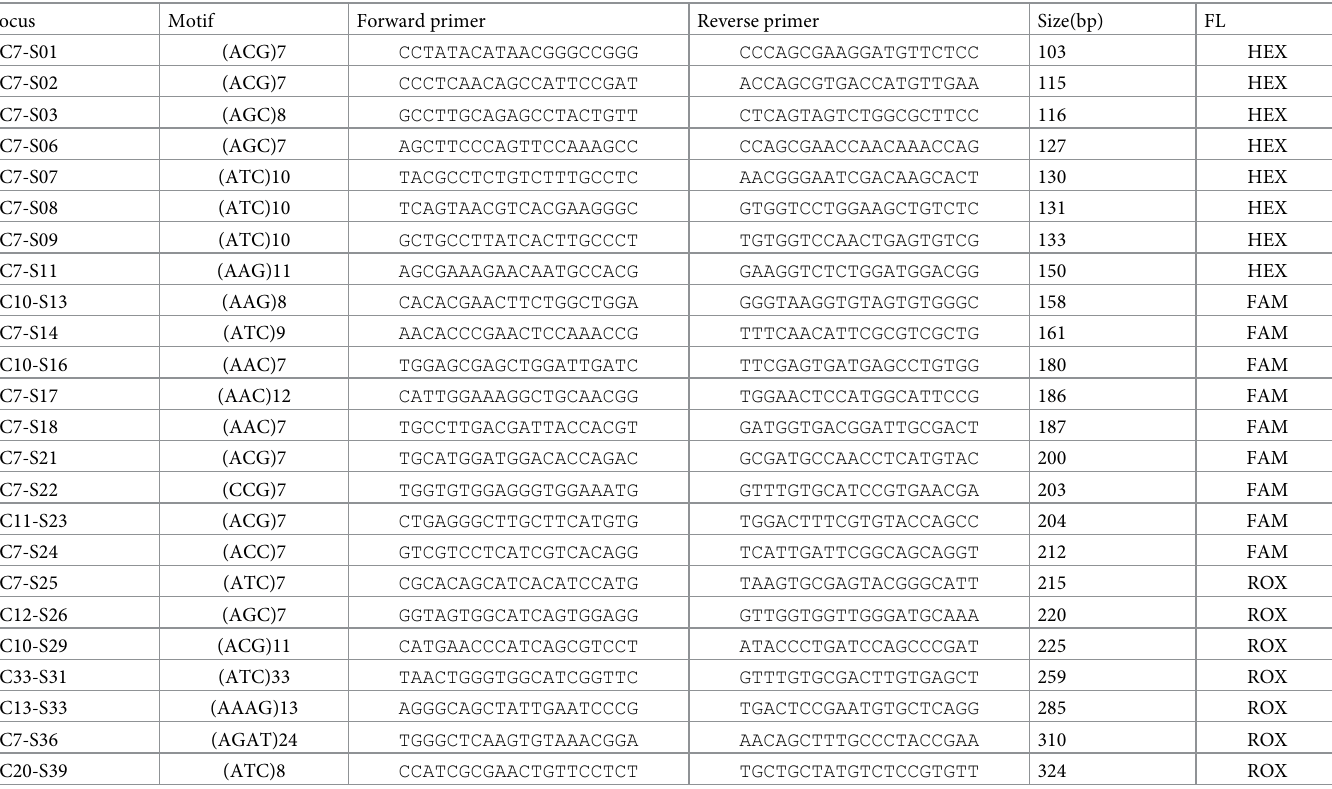
Table 2. Twenty-four microsatellite loci developed for Eupeodes corollae .